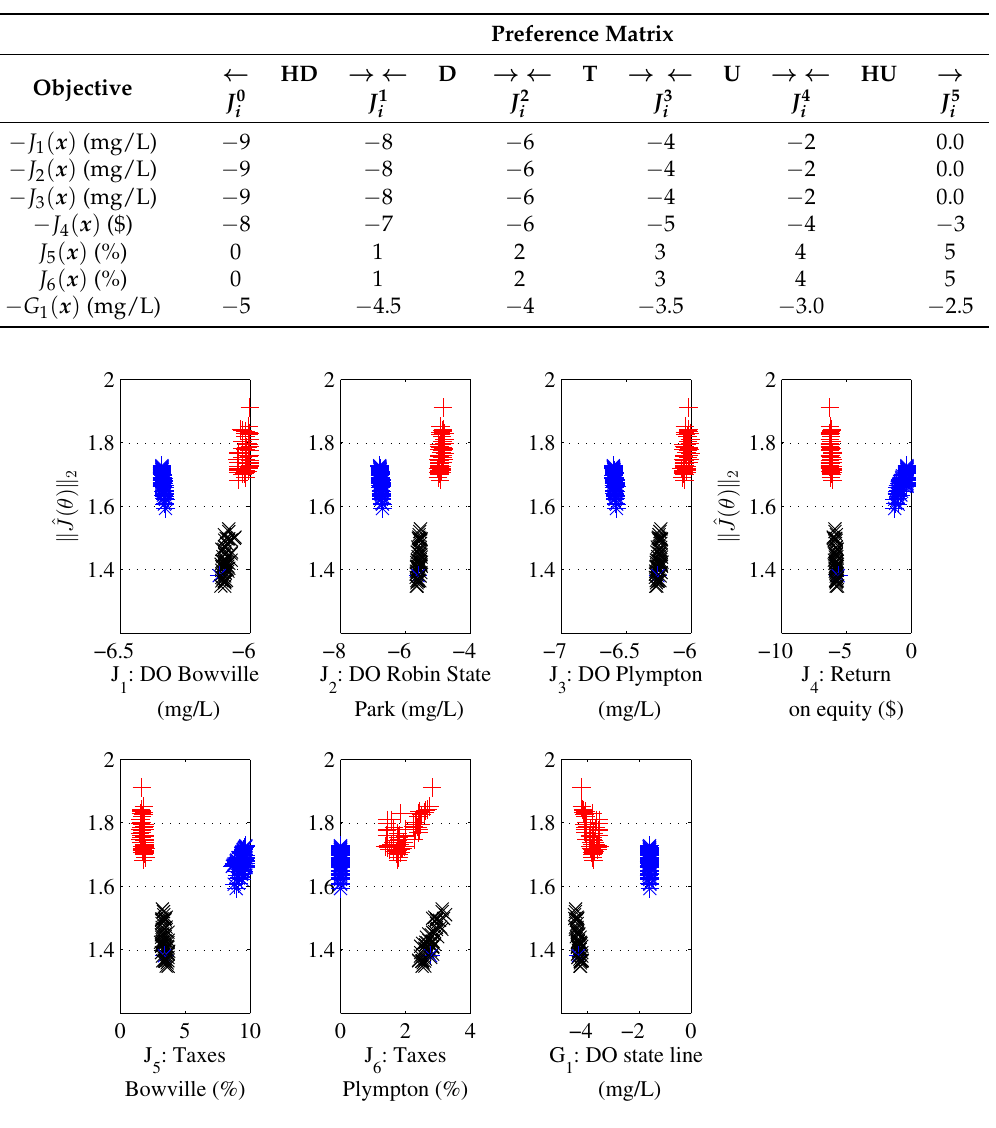
Figure 3. Pareto front approximation for MOP II with preference pruning: PP (red + ); PROMETHEE II (blue ∗ ) and TOPSIS (black